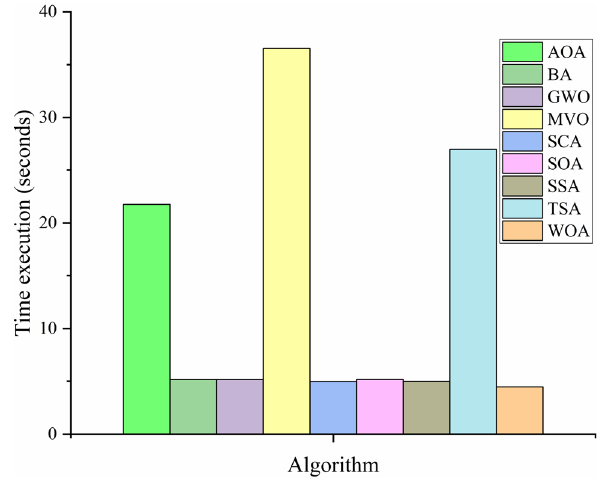
Fig. 22 The time execution of the algorithms for case